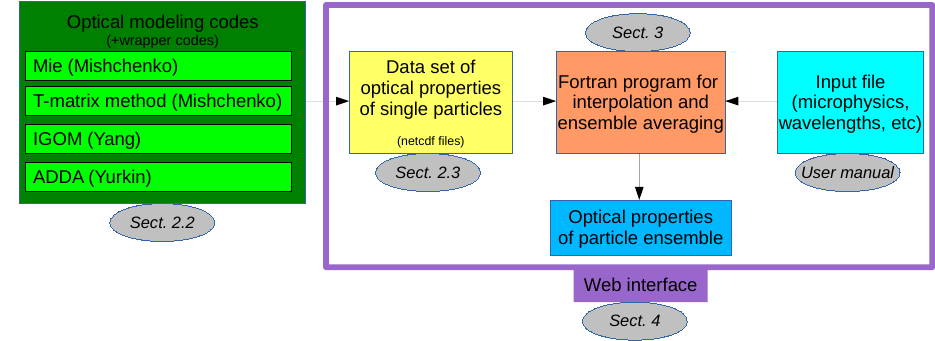
Figure 1. Scheme of the MOPSMAP package, including the optical modeling codes applied to create the data set.